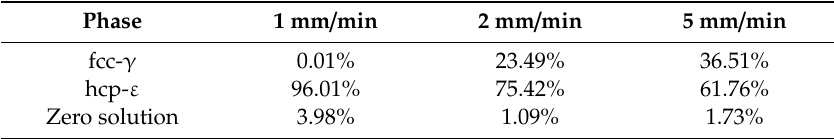
Table 1. The ratio of each phase and zero solution in the Co-Cr-Mo